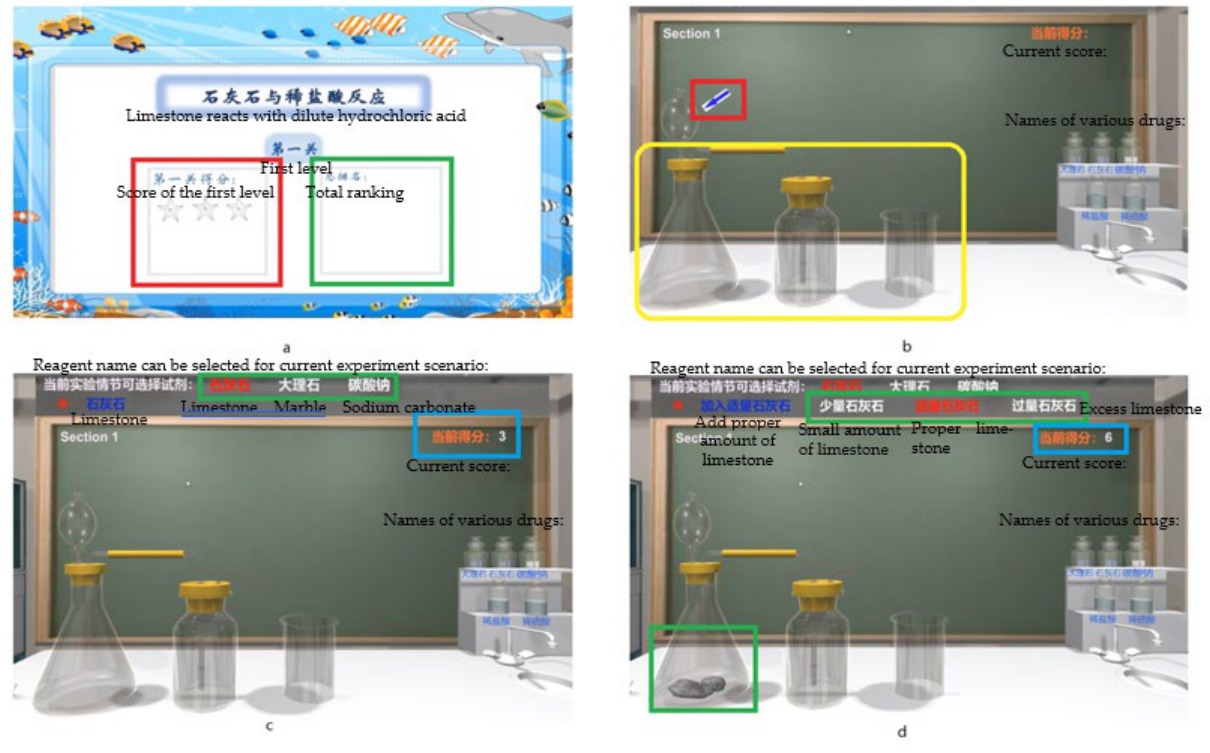
Figure 6. Limestone and dilute hydrochloric acid experiment scene 1. ( a ). The first test interface. ( b ). Knowledge Q&A interface. ( c ). Drug selection interface 1. ( d ). Drug selection interface 2.